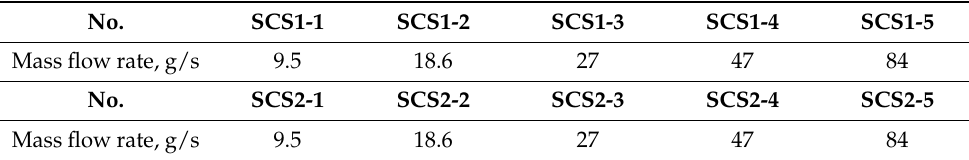
Table 4. Actual values for each experimental